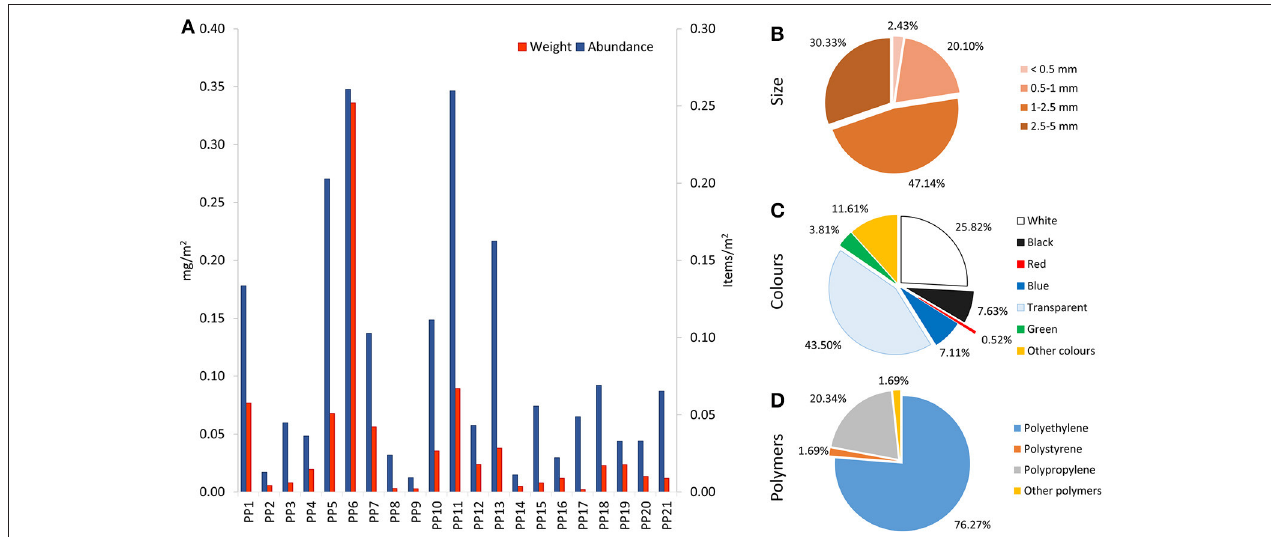
FIGURE 1 | Microplastic abundance and characterization in the Pelagos Sanctuary. (A) Microplastic abundance (items/m 2 ) and weight (mg/m 2 ) in the different sampling sites; (B) microplastic size; (C) microplastic color; (D) microplastic polymers.